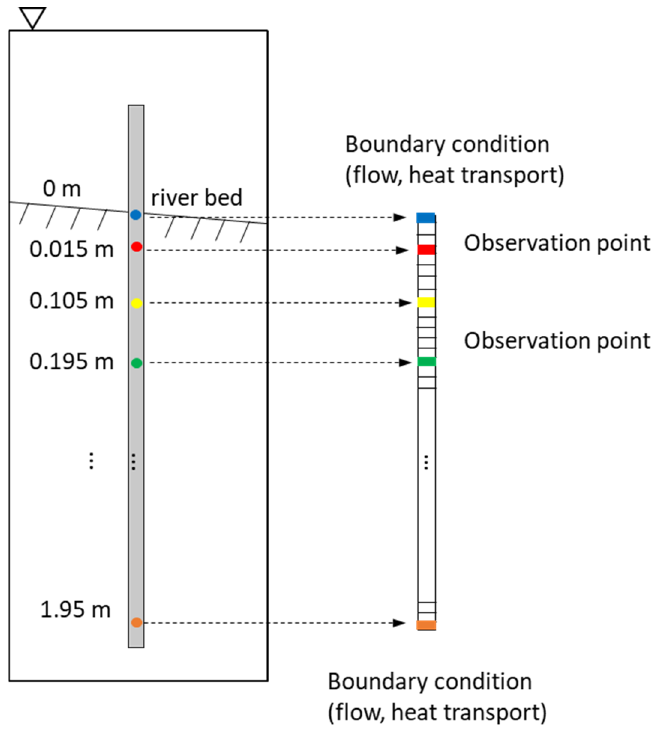
Figure 1. Depths of the temperature and pressure observations.